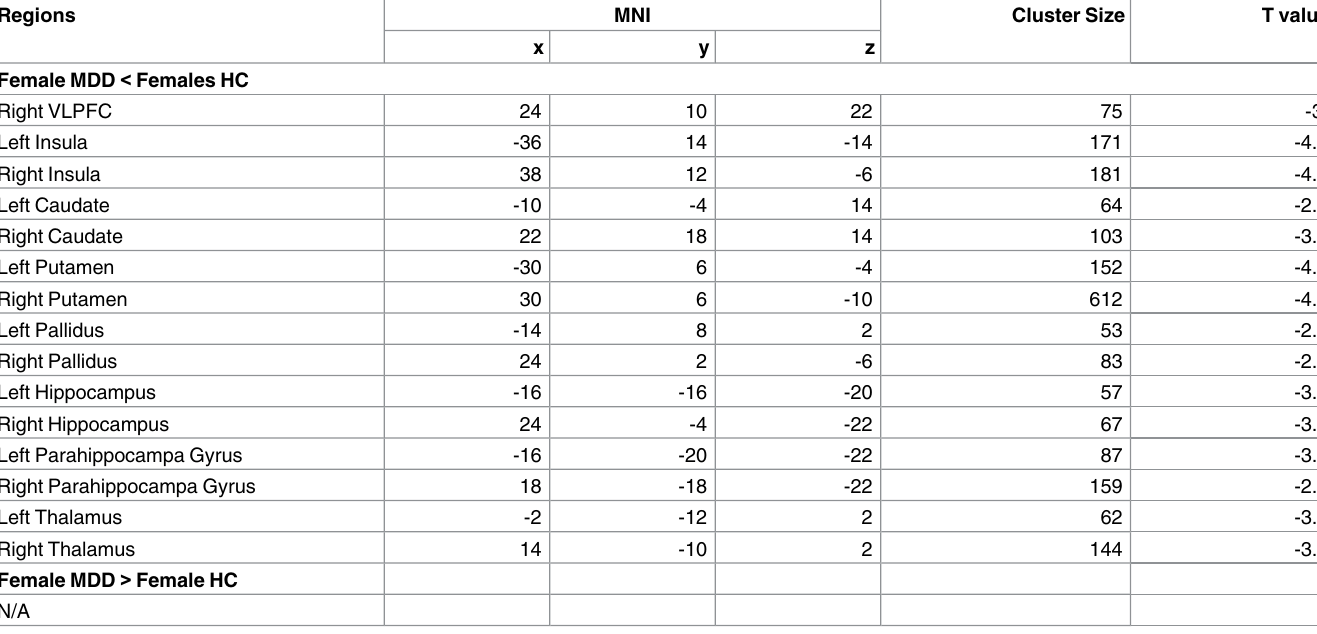
Table 3. The locations of the regions showing significantly altered connectivity with the amygdala in females with MDD compared to HC. Regions MNI Cluster Size T value